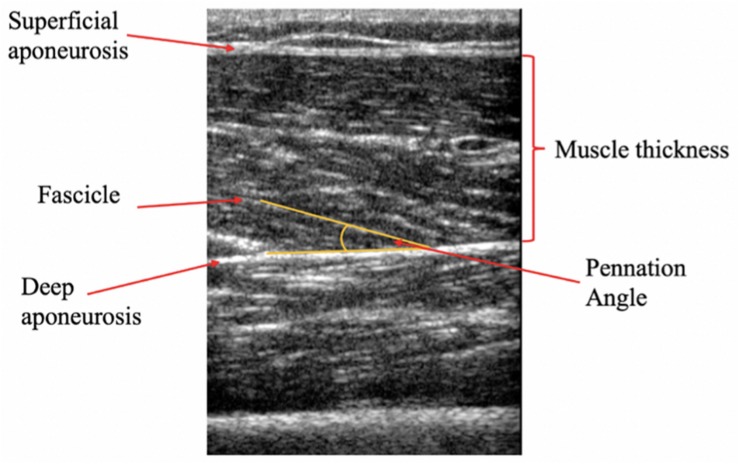
Representative longitudinal B-mode ultrasound image of the Vastus lateralis (VL). Muscle pennation angle is represented at the angle between the fascicle and the deep aponeurosis, whilst muscle thickness is defined as the distance between the inside borders of the deep and superficial aponeurosis.